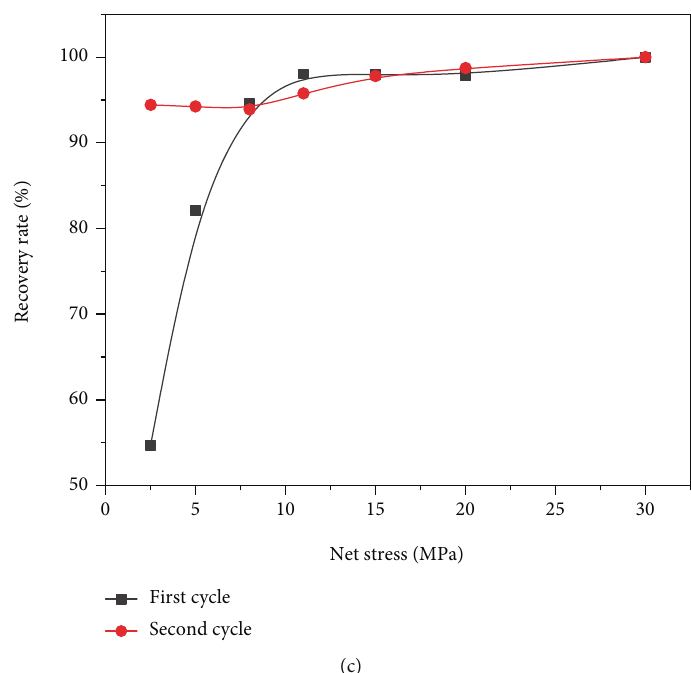
Figure 4: (a) The relation between dimensionless permeability and net stress; (b) permeability damage rate during cyclic loading; (c) permeability recovery rate during cyclic loading.